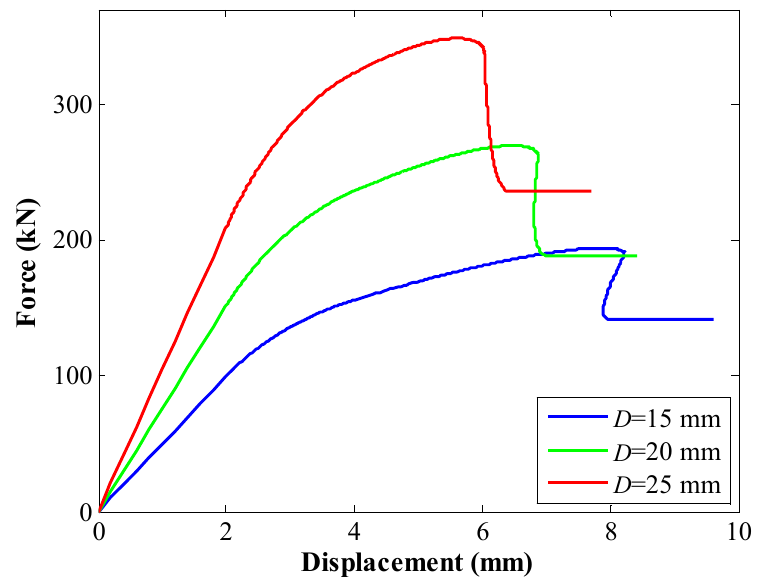
Figure 3. Effect of bar diameter on the load-carrying force of bars.